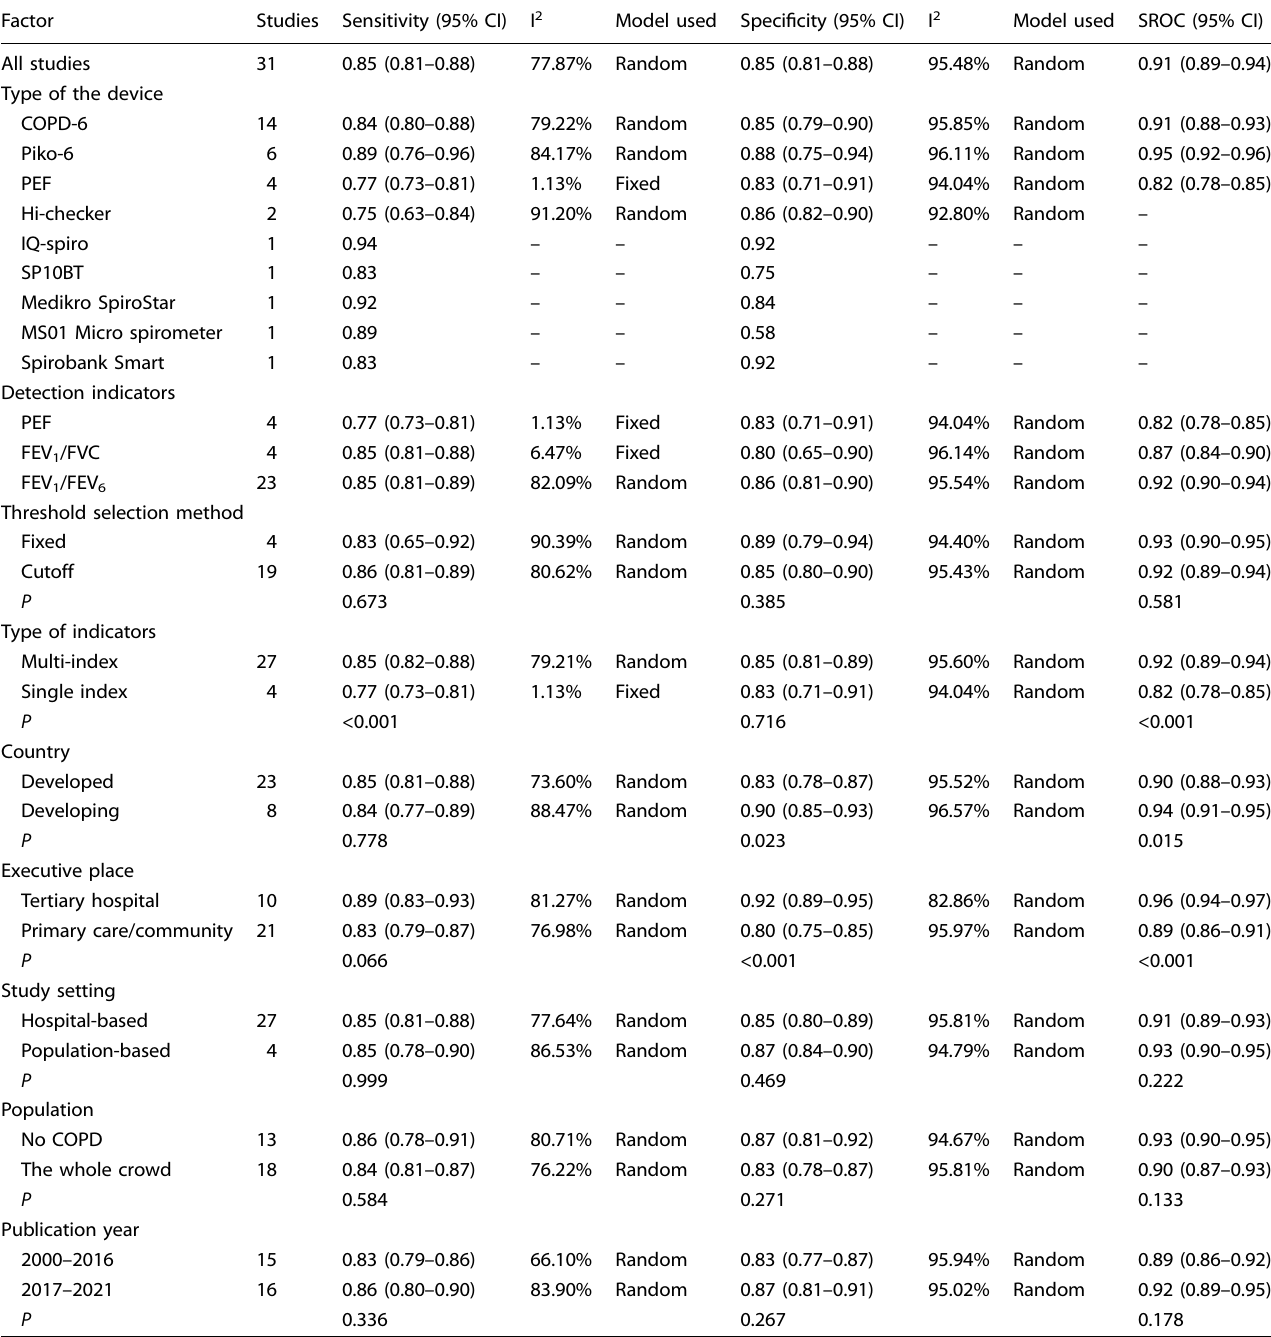
Table 2. Subgroup analysis of all included